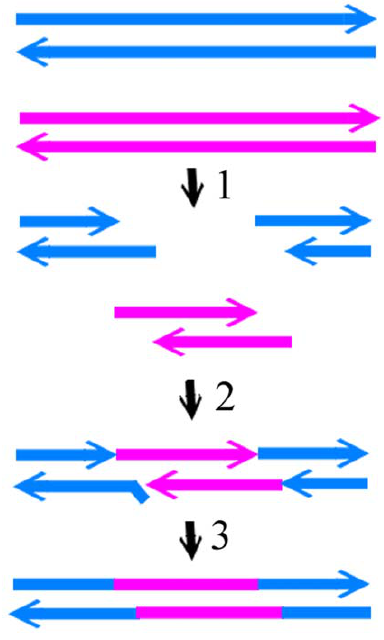
Figure 5. The mechanism of endonucleolytic cleavages at equivalent sites and strand annealing (CESA). T7 and T3 DNA are shown in blue and pink, respectively. Arrows indicate the 3 9 end. The steps are: 1, cleavage of T3 and T7 genomes by Endo I at equivalent sites; 2, annealing of the DSBs at both ends of T3 genome with the T7 DSB from the middle of the genome; 3, displacement and removal of the nonhomologous region, then filling the gap and ligation of the ends.